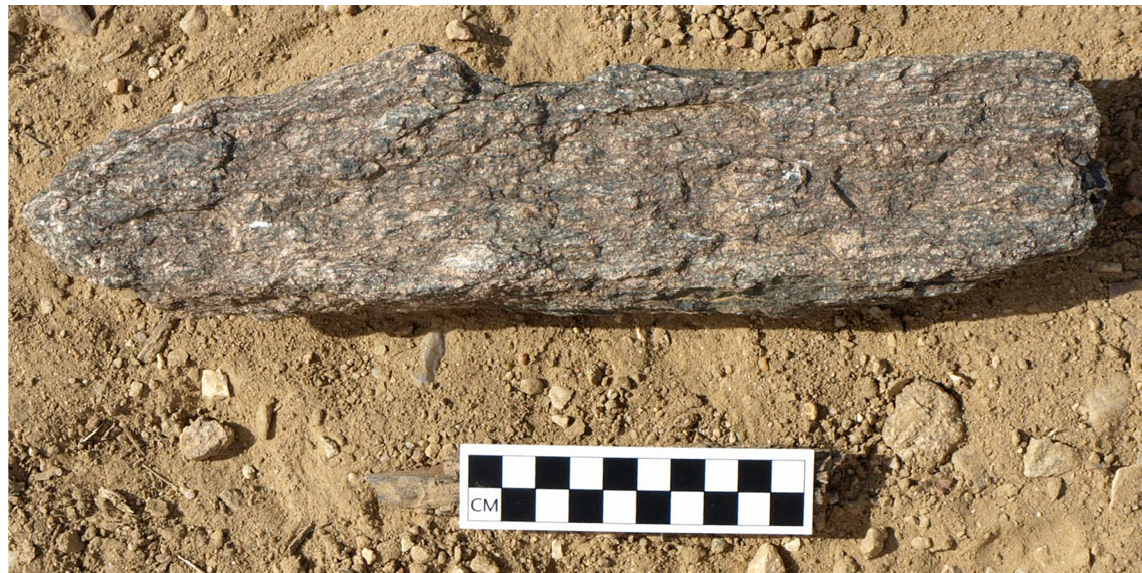
Figure 13. Specimen FN-097, a pick and mattock tool made from schist. Note the pointed pick-like end to the left and the broader mattock-like end to the right. This implement has an irregular plano-convex cross- section. (Photograph by James Neely.)